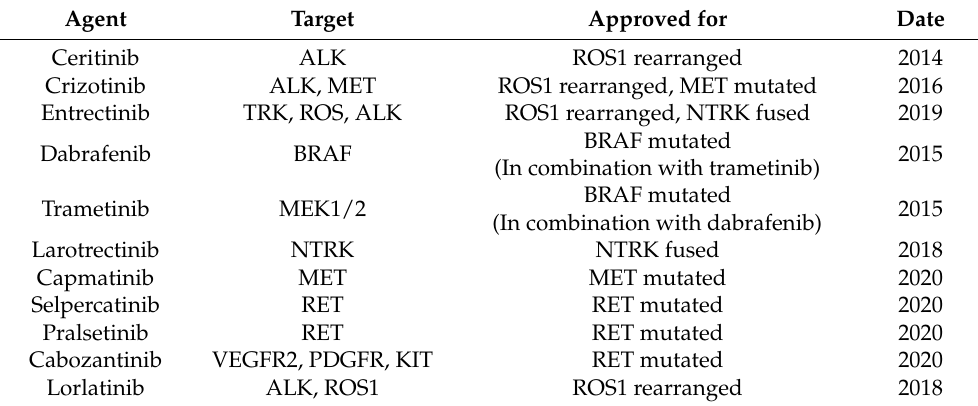
Table 1. FDAapproved pharmaceutical agents to treat NSCLC gene alterations.